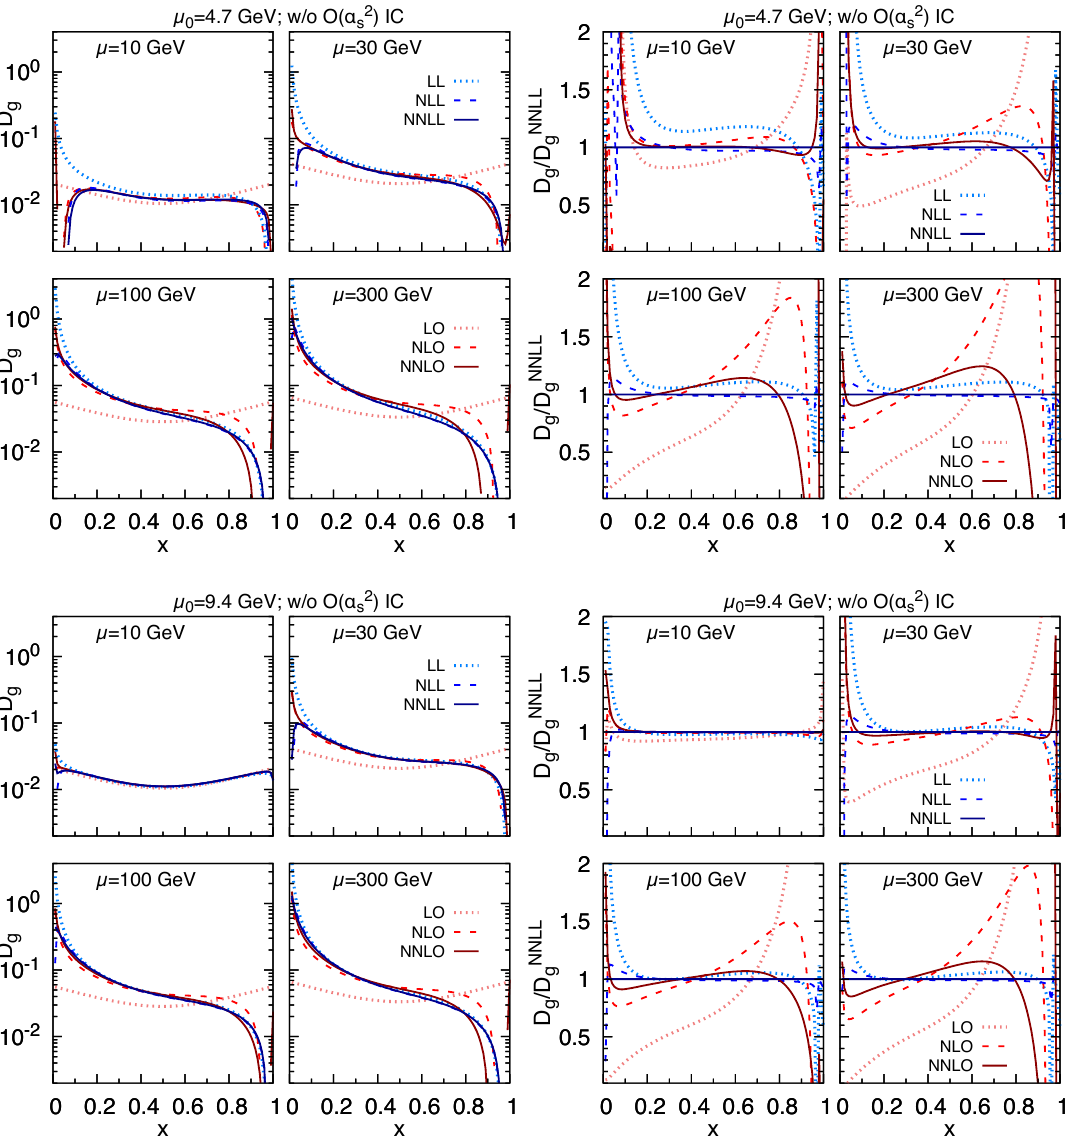
Figure 4 . Same as (cid:12)gure 3, for the gluon fragmentation